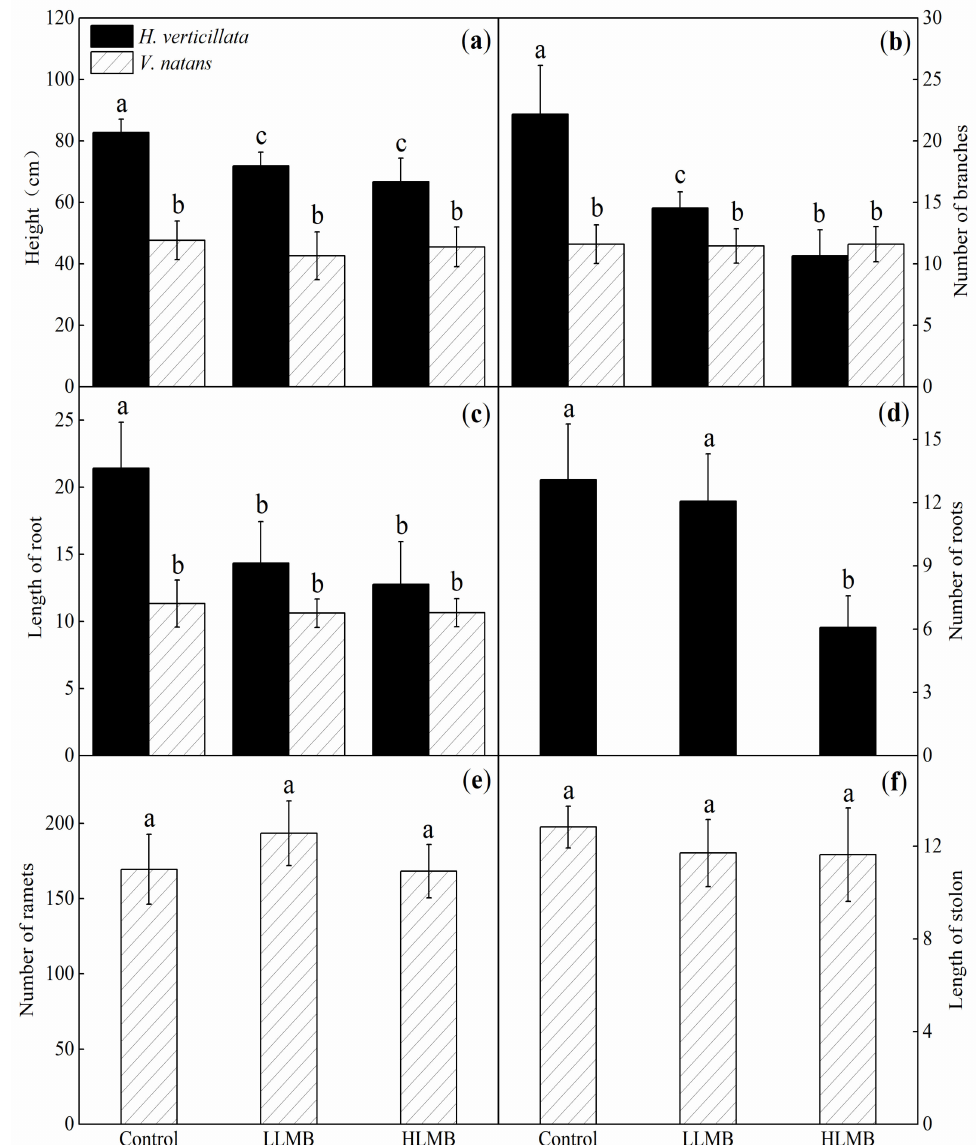
Figure 5. Height ( a ), branch number ( b ), root length ( c ), root number ( d ), ramet number ( e ), and stolon length ( f ) of H. verticillata and V. natans . Factor was LMB (0, 425 g m − 2 , and 850 g m − 2 ). The values represented a standard deviation. Means with different letters (a, b, and c) were significantly different ( p <